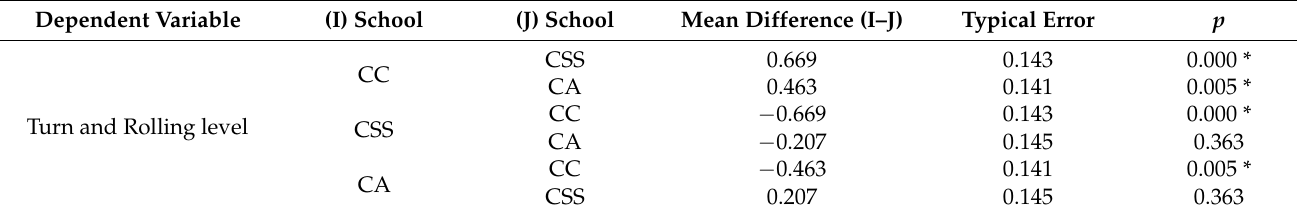
Table 6. Significance of the difference in the level of rolling skill between